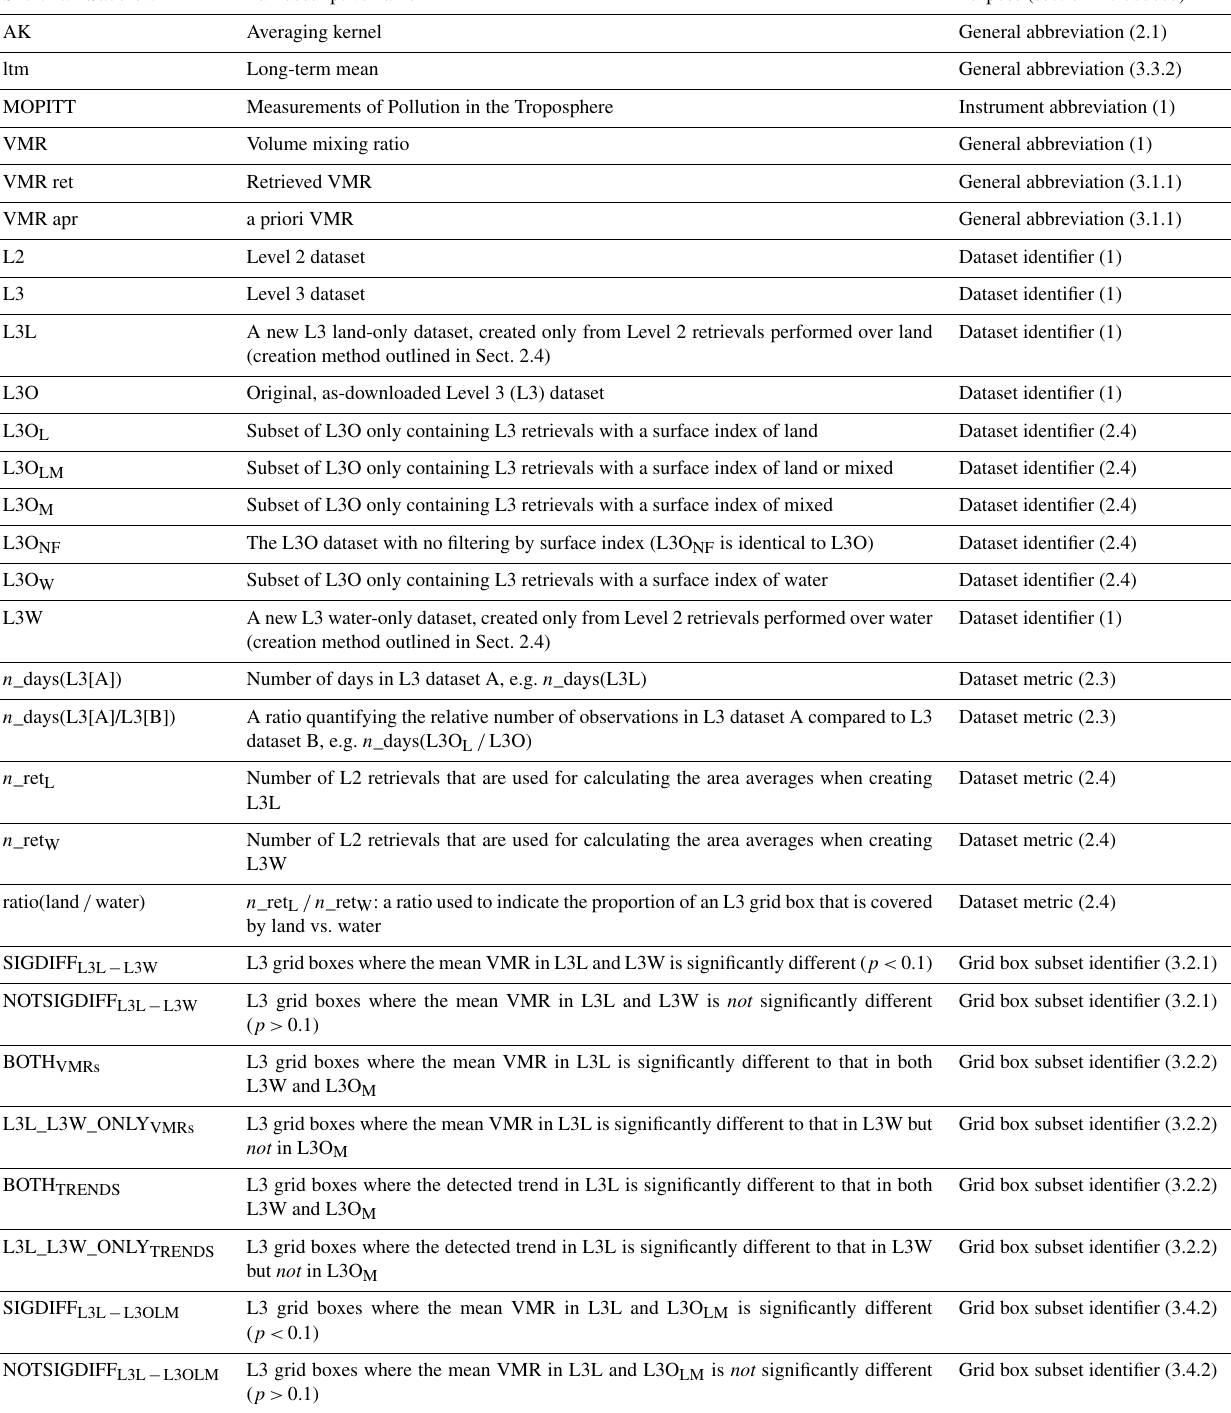
Table A1. List of short names and abbreviations used in the main article text, their full descriptive name, and the purpose of use (along with the section they are first